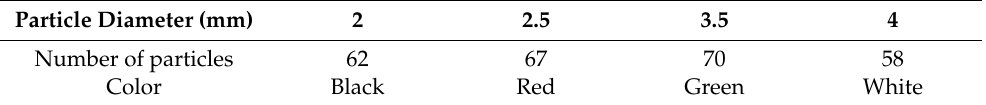
Table 1. Particle sizes used in the settling experiment.